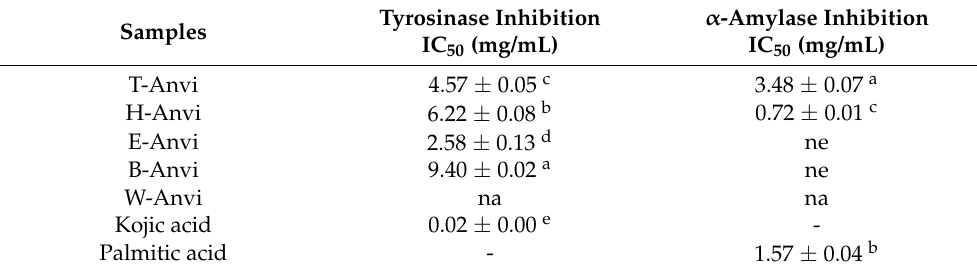
Table 3. Tyrosinase and α -amylase inhibitory activities of A. virginicus extracts. Samples